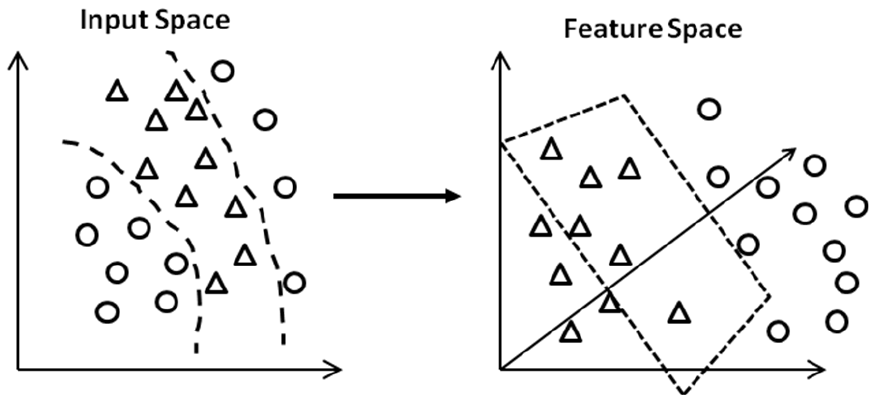
Figure 7. Mapping of the data from the input space to a high-dimensional feature